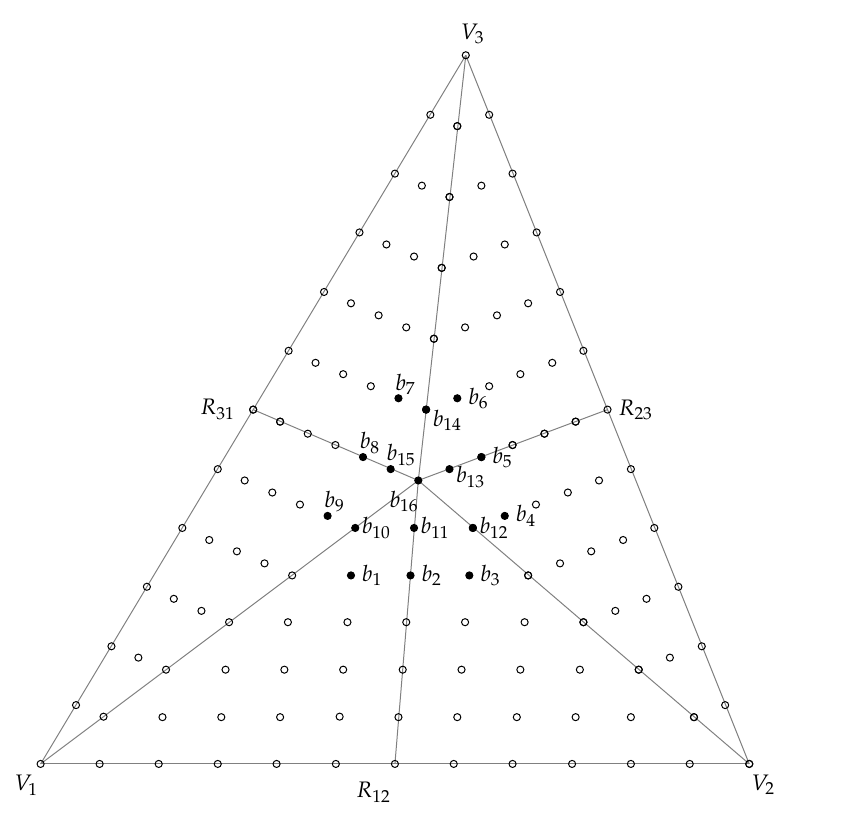
Figure 6. Schematic representation of the Bézier ordinates of a B-spline with respect to a triangle. The B-coefficients that are known to be zero are indicated by open ◦